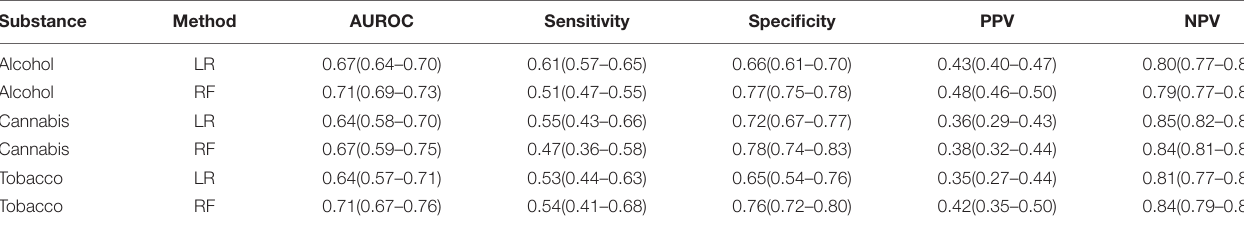
TABLE 3 | Overall evaluation measures for the prediction of participant success for alcohol, cannabis and tobacco using Logistic Regression (LR) and Random Forest (RF).